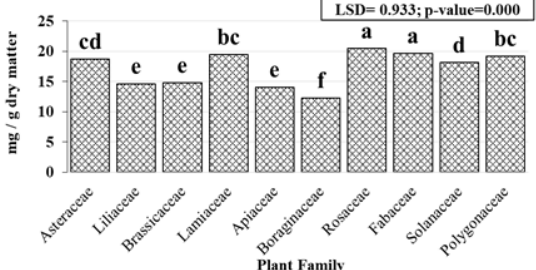
Fig. 11. Mean value for the accumulation of phenolic compounds in plant family regardless of plant species (mg/g dry matter equivalent to mg gallic acid/dry matter).